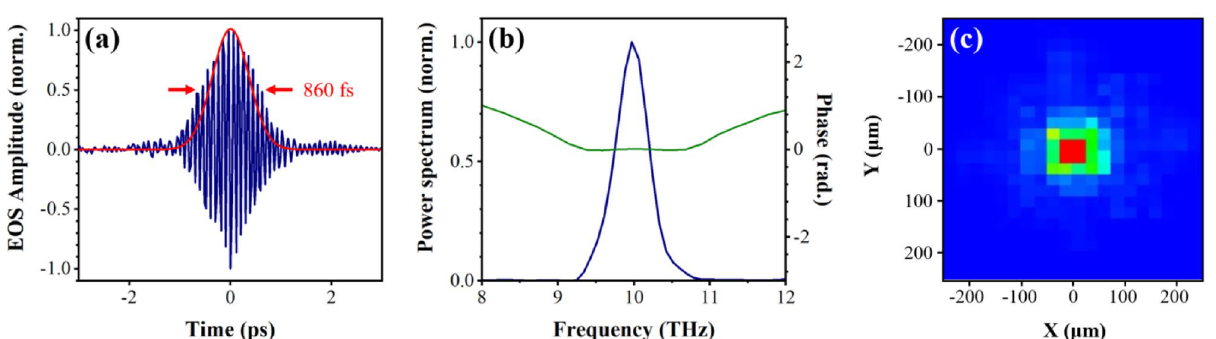
Figure 5. Characterization of the narrowband, phase-stabilized THz pulses generated via DFG. ( a ) THz electric field measured by the EOS method with temporal intensity profile (solid red line) ( b ) The corresponding power spectrum (solid blue line) with spectral phase (solid green line) ( c ) Focused THz beam profile at the EOS crystal